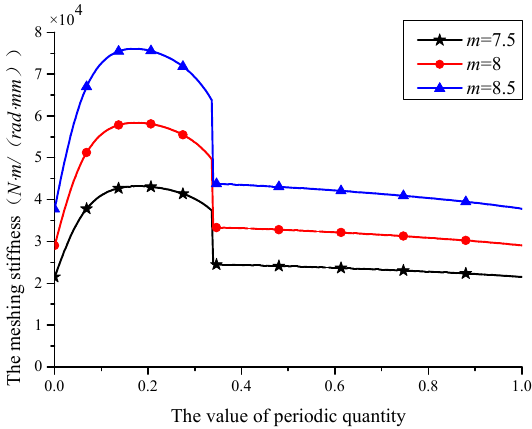
Figure 25. Influence rule of m on meshing stiffness.